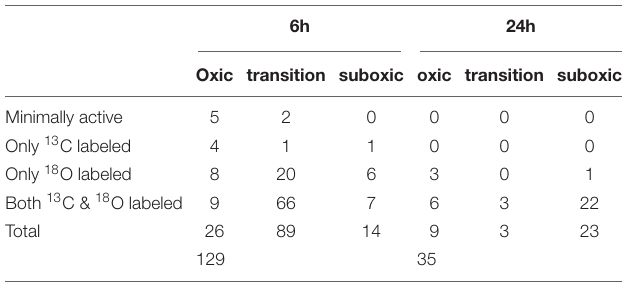
TABLE 3 | Number of cable bacterium filament fragments with a specific 13 C labeling of their cytoplasm and 18 O labeling of their poly-P granules. 6h 24h Oxic transition suboxic oxic transition